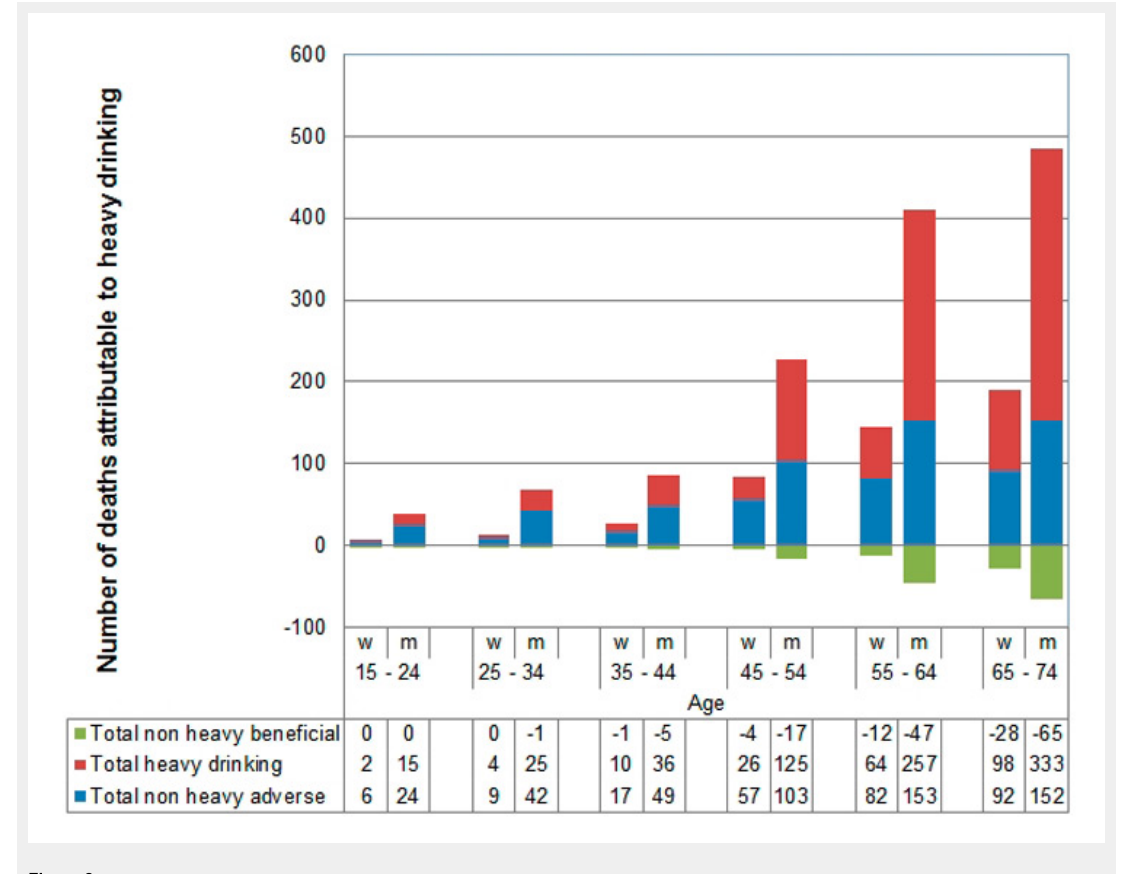
Figure 2 Alcohol-attributable deaths due to heavy drinking (60 g+/day for men, 40 g+/day for women) and non-heavy